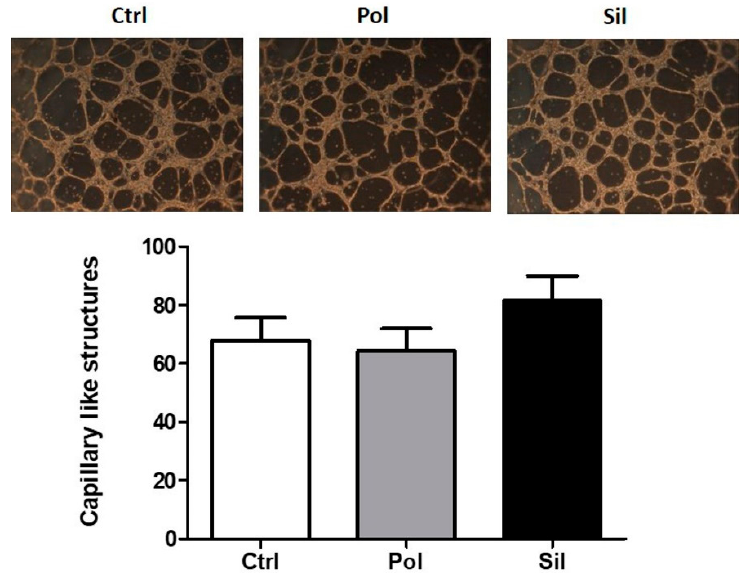
Figure 12. E ff ects of nanoparticles in cell migration and tubulogenesis HUVEC were cultured for 24 h in the absence (ctrl) or in the presence of 20 ug / mL of polymeric (Pol) or silica (Sil) nanoparticle Endothelial sprouts were quantified by counting the sprouts in four high-power microscopic fields (at 100 × magnification) in each treatment. ( A ) Representative structures formed; ( B ) total number of structures formed by cells. Results are shown as the mean obtained from three individual experiments (* p < 0.05).